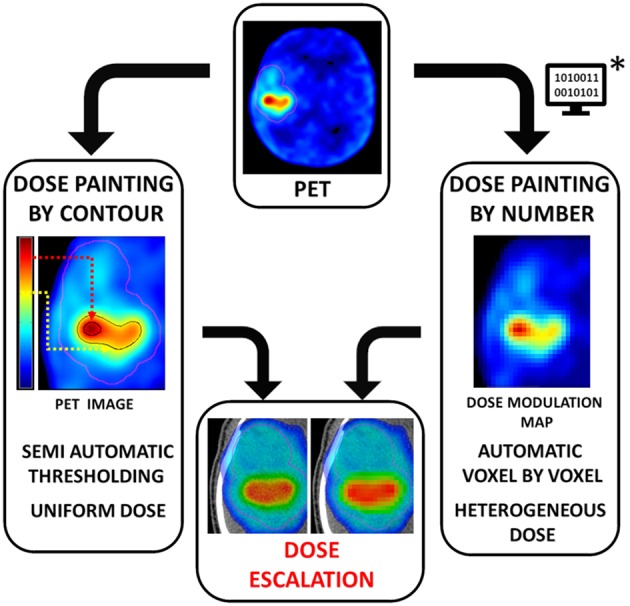
The two main approaches of dose painting: by contour (DPBC) or by number (DPBN). For DPBC, added to the standard clinical dose level (in pink), the radiation oncologist manually delineates a uniform HTV (in black) corresponding to a subjective PET-uptake level threshold (dashed line). Note that both methods use PET images, but DPBN requires a mathematical data pre-processing step (*) that computes PET image into a “dose modulation map.” When performed, dose painting allows RT dosimetric simulation for optimal dose escalation.